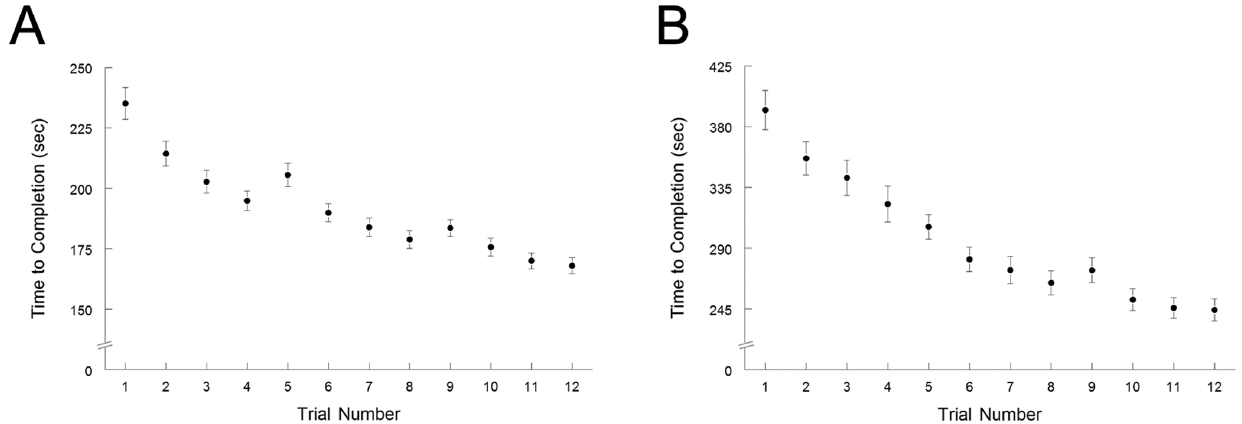
Figure 3. Motor learning data across each week. The average time to completion of each 100-target trial for days 1–3 (4 trials per day) on the MNT for (A) week 1 and (B) week 2. Mean 6